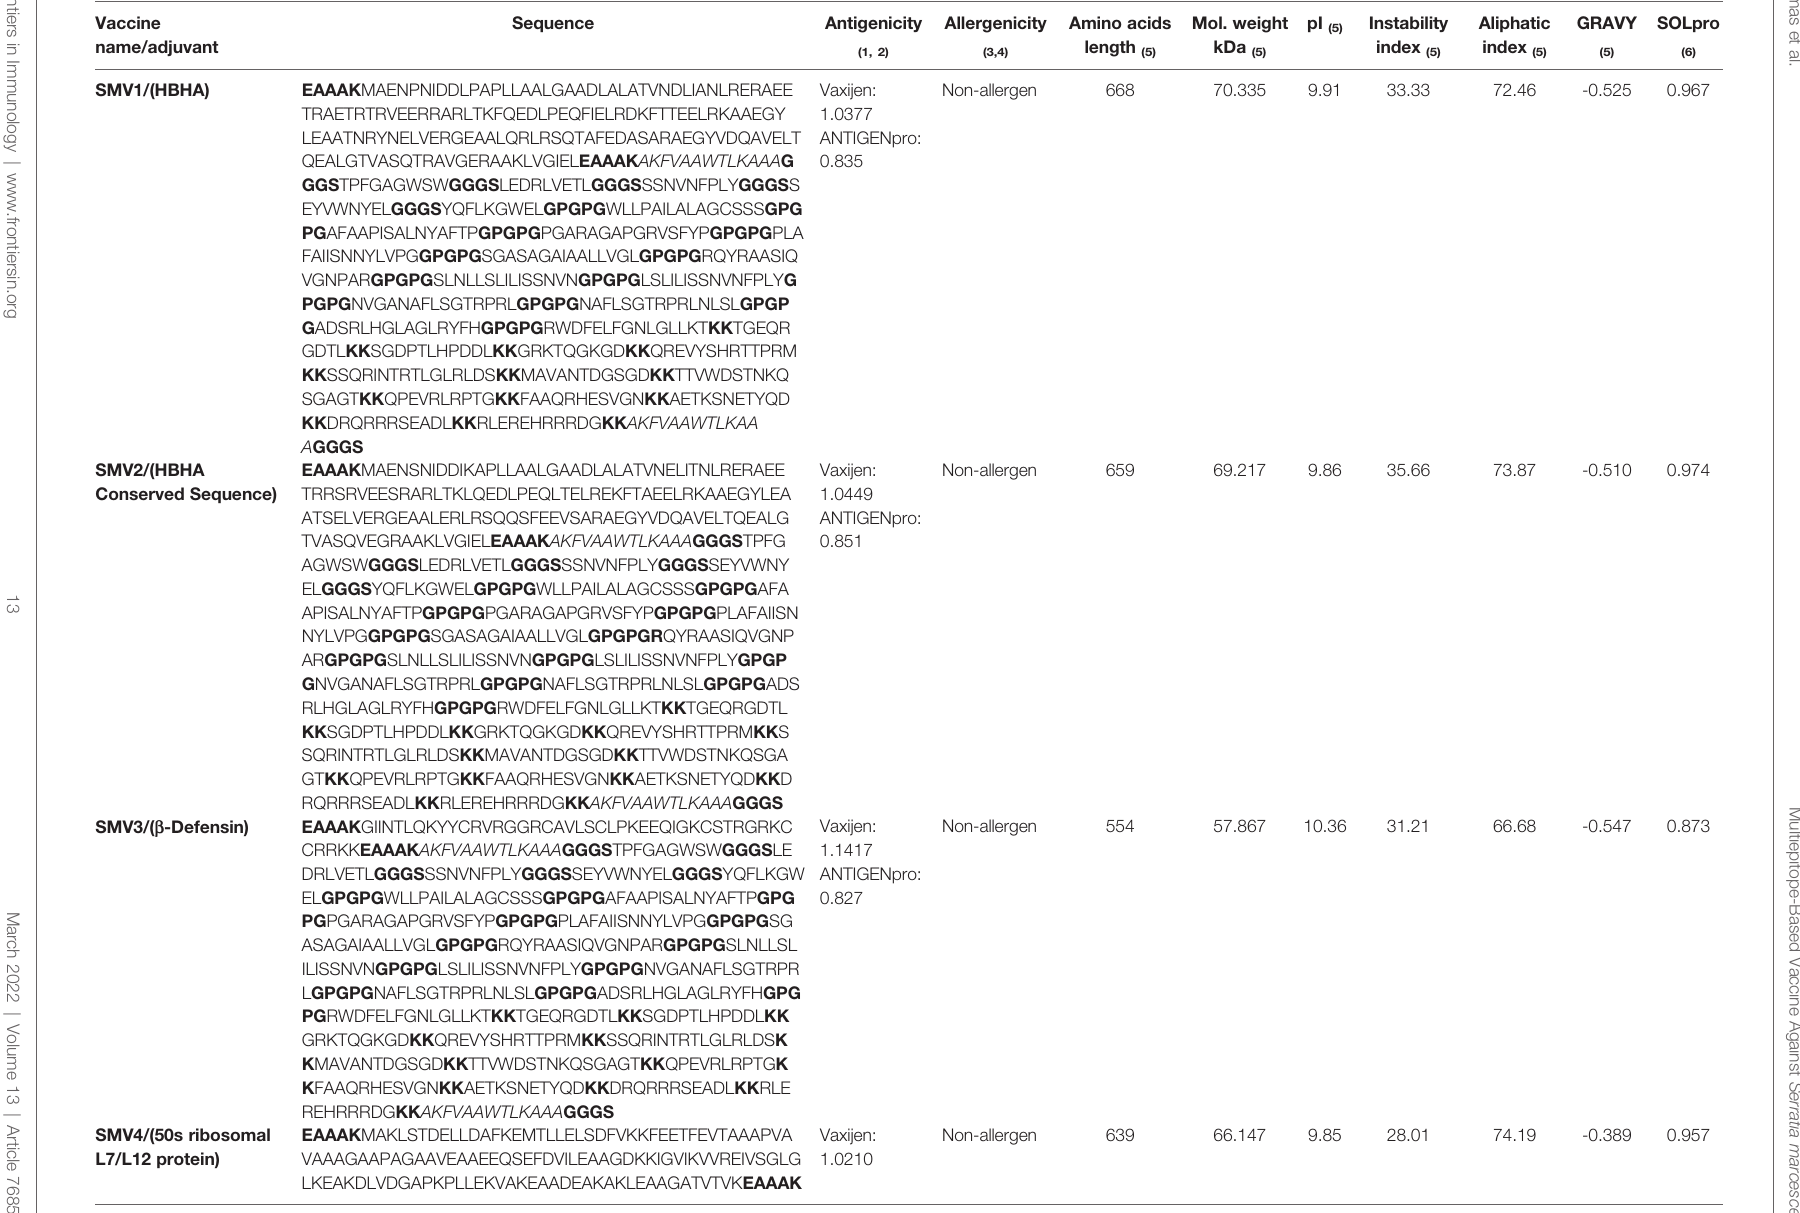
TABLE 6 | Characteristics of the constructed vaccines against S. marcescens